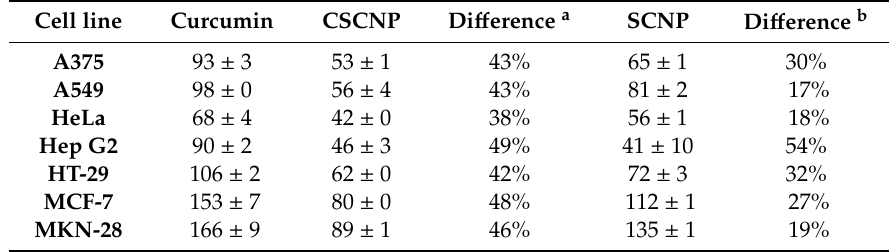
Di ff erences were shown as the percentage decrease in IC 50 after nanoencapsulation. SCNP: silica-encapsulated curcumin nanoparticles; CSCNP: chitosan with silica co-encapsulated curcumin nanoparticles. Di ff erence a and di ff erence b were calculated by the following formulas: Di ff erence a = 100 − (CSCNP IC 50 / Curcumin IC 50 ) × 100; Di ff erence b = 100 − (SCNP IC50 / Curcumin IC 50 ) ×